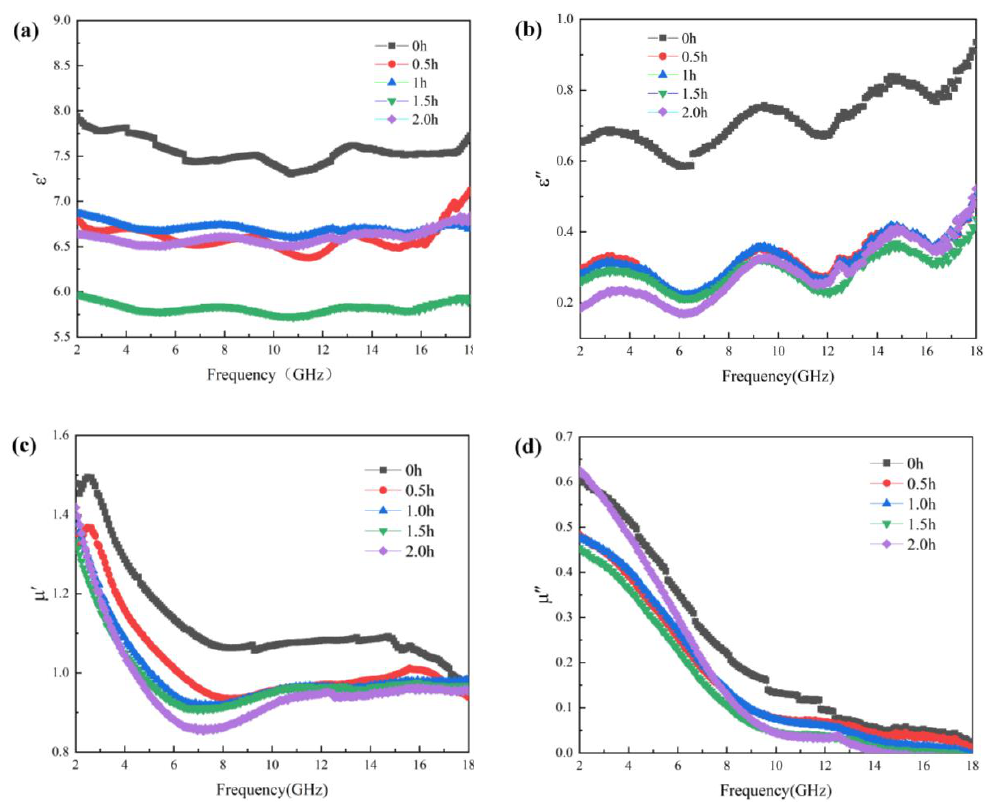
Figure 4. Complex permittivity and complex permeability of the Fe 3 O 4 absorption material at di ff erent grinding times. ( a ) Real part of the complex permittivity; ( b ) Imaginary part of the complex permittivity; ( c ) Real part of the complex permeability; ( d ) Imaginary part of the complex